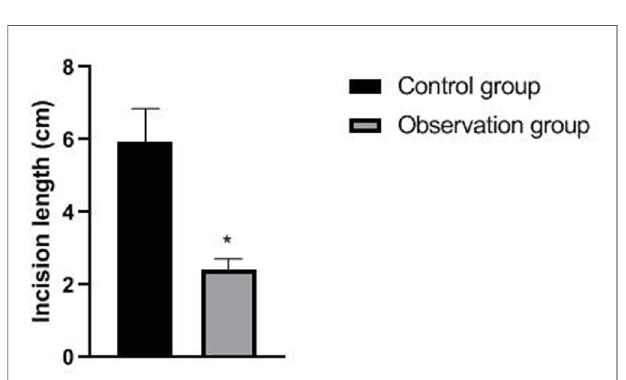
FIGURE 2 | Comparison of incision lengths between the two groups. Note: compared with the control group, * p